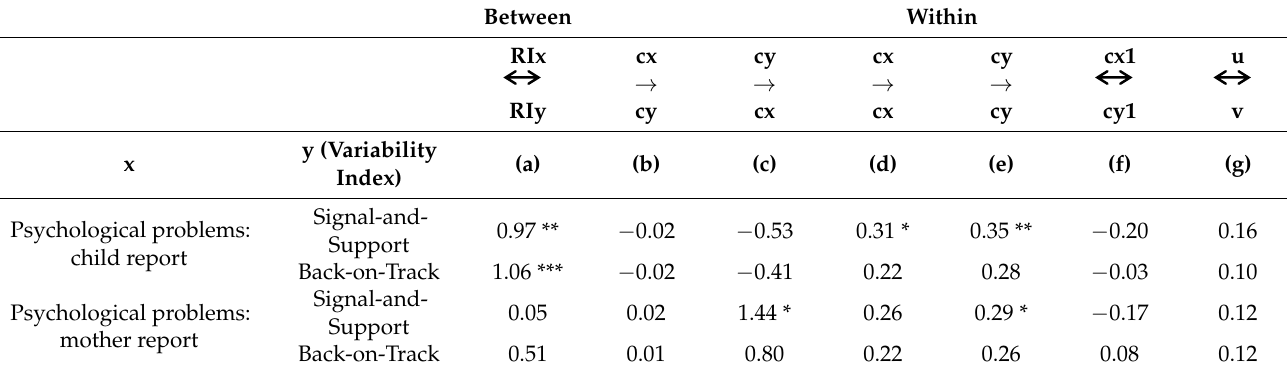
Table 5. RI-CLPM results with Trust.